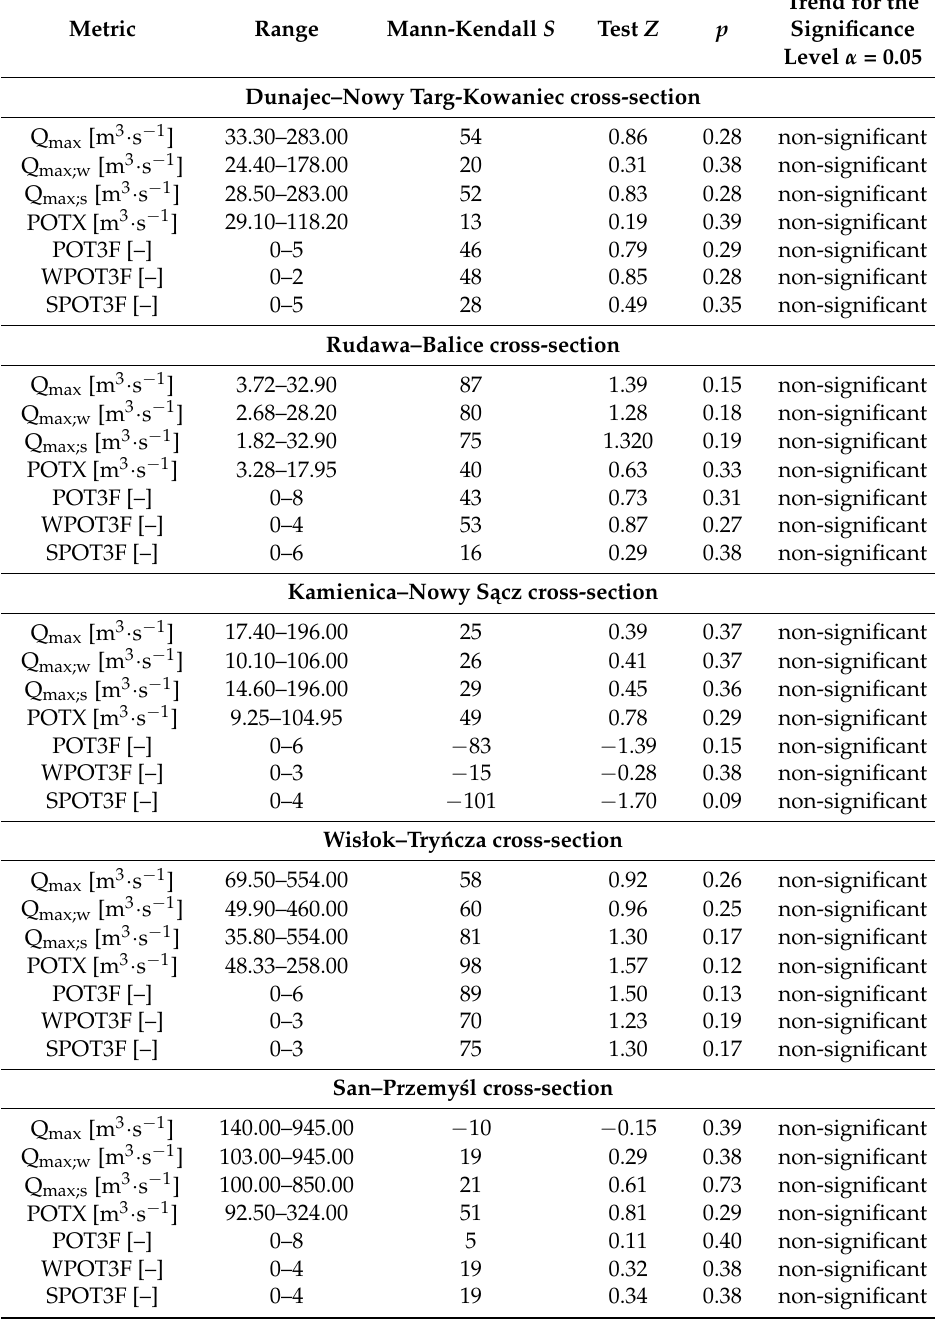
Table 2. Evaluation of the trend of the analyzed metrics describing high water stages in the catchments of the study